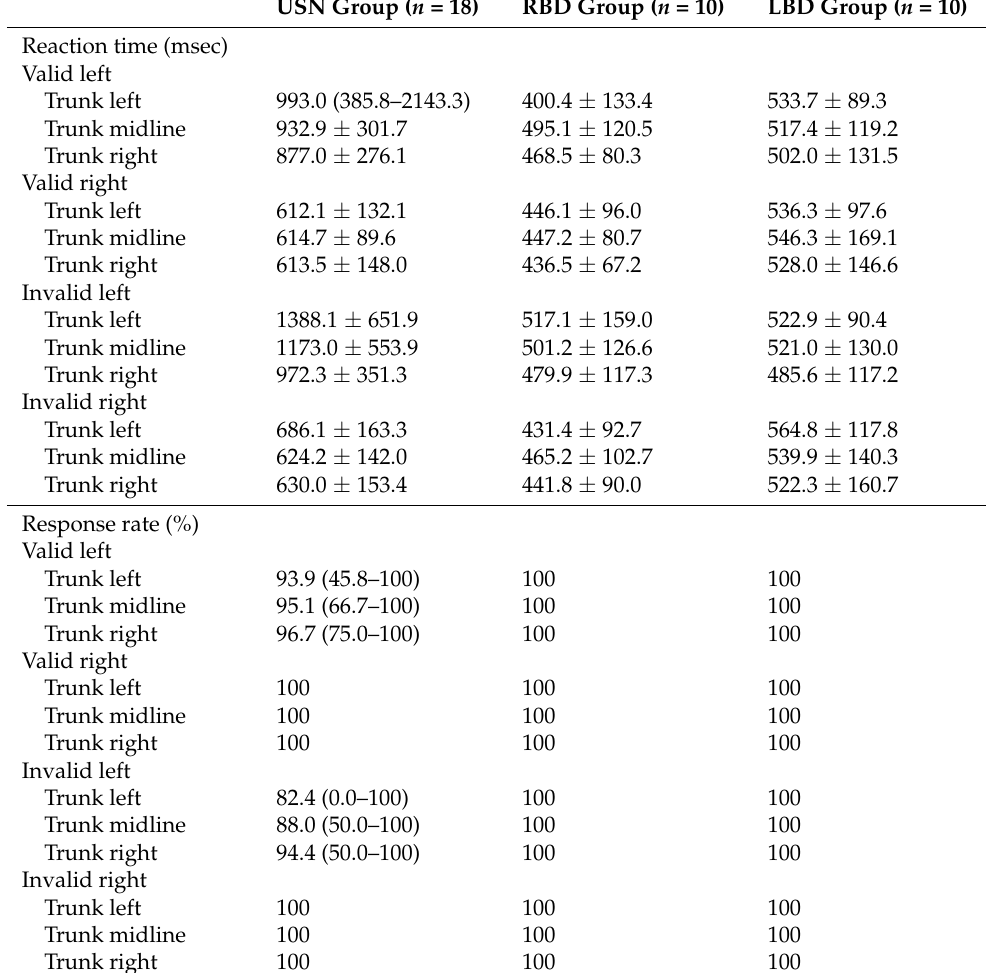
Table 2. Results of the modified Posner task (MPT) in the RBD and LBD